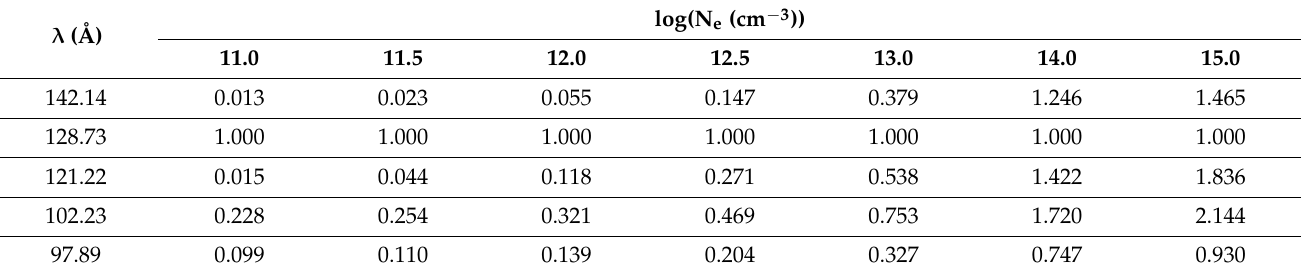
Table 5. Intensity ratios as a function of electron